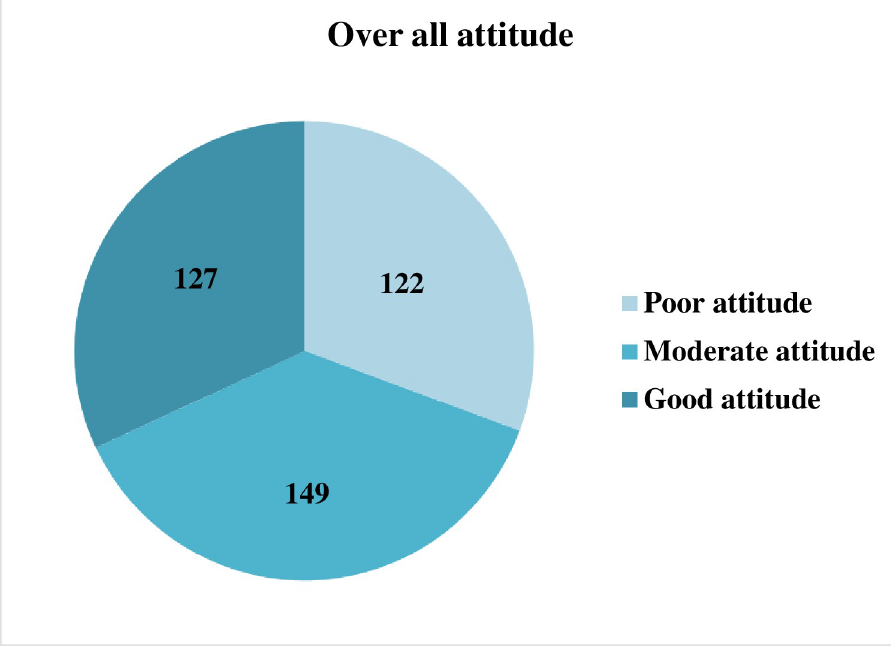
Fig 3. Level of overall attitude towards COVID-19 among outpatient service visitors at Debre Markos compressive specialized hospital, Amhara regional state, Ethiopia, 2020.